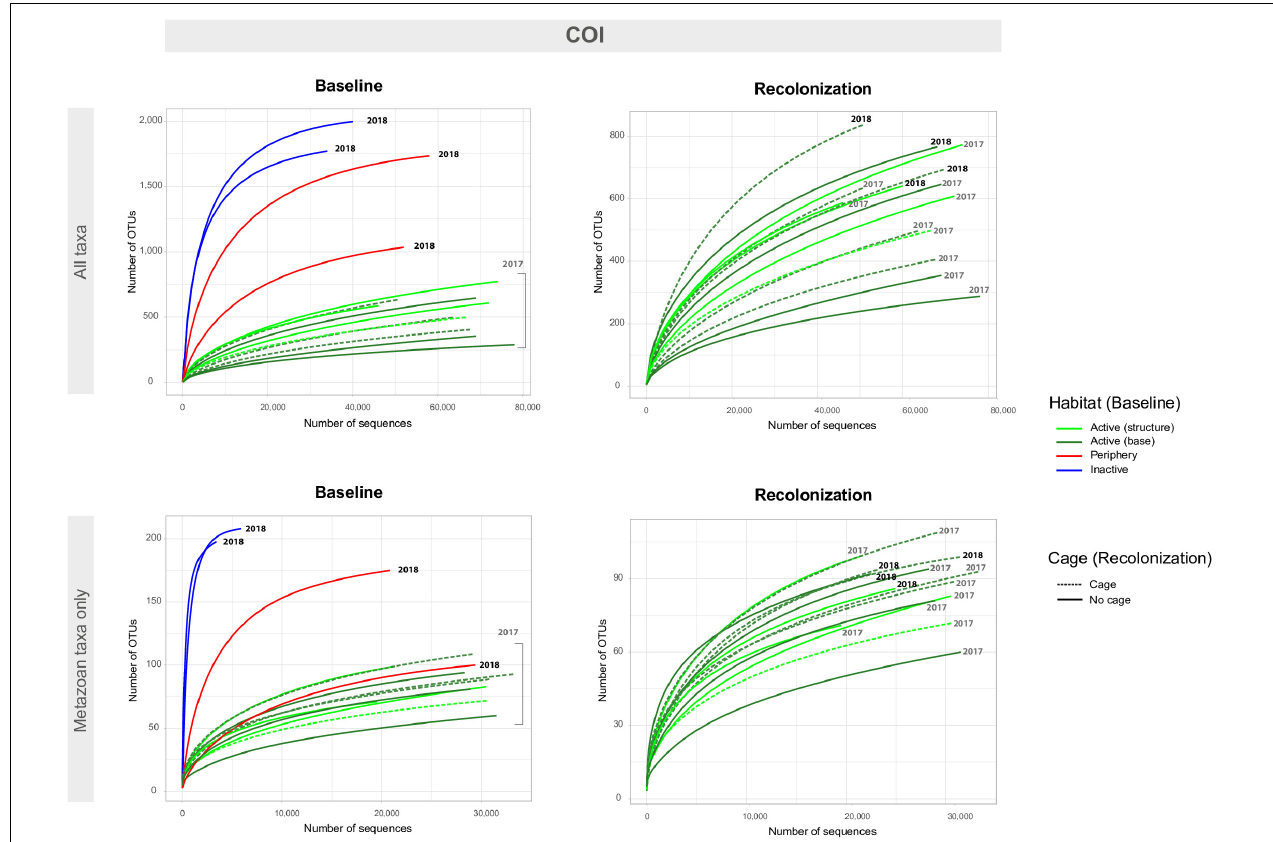
FIGURE 5 | Accumulation curves for the COI eDNA dataset, for both baseline (left) and recolonization (right) data across all taxa (non-metazoans and metazoans, top ) and metazoan taxa only (bottom) . Baseline data focuses on sample communities from differing habitats/vent activity, as well as those from differing locations on the active edifice (base and structure). Recolonization data focuses on sample communities from differing years, as well as those that were caged against those non-caged at active sites. Note the difference in scales for number of OTUs and number of sequences between “All taxa” and “Metazoan taxa only.” Recolonization data are only available for the active